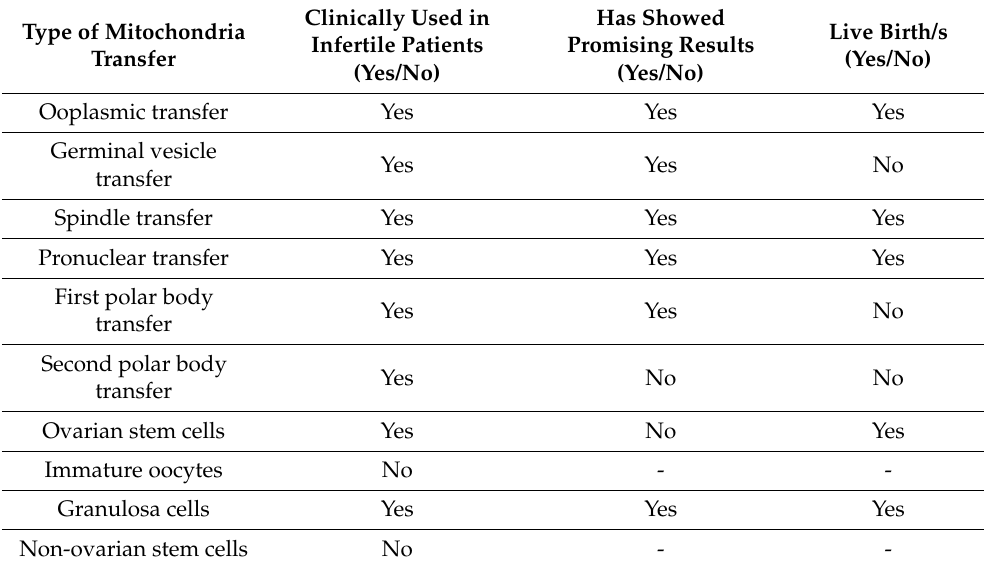
Table 3. Summary table of the clinical use in infertile patients and the main results of the different techniques here described. Clinical use is defined as: Has Showed Clinically Used in Live Birth/s Type of Mitochondria Promising Results Infertile Patients Transfer (Yes/No) (Yes/No)